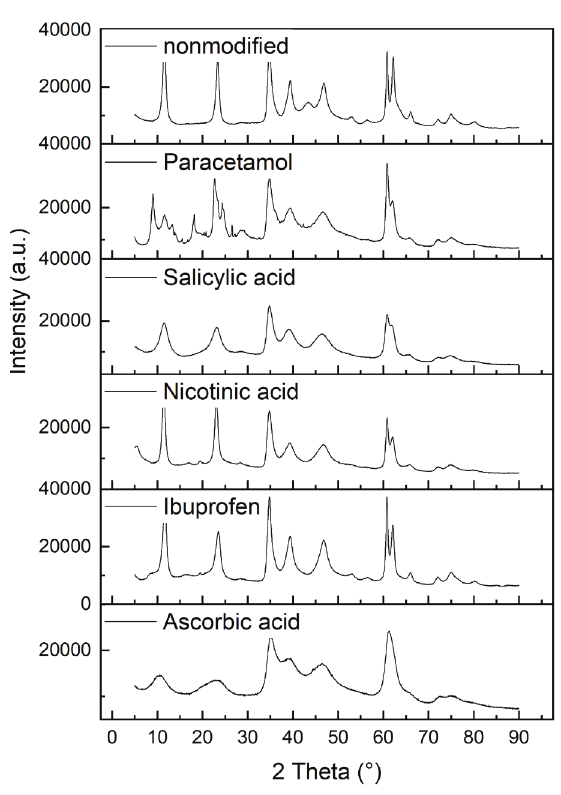
Fig. 3 – X-ray diffractogram of prepared Ni-Mg-Al and Zn-Al materials